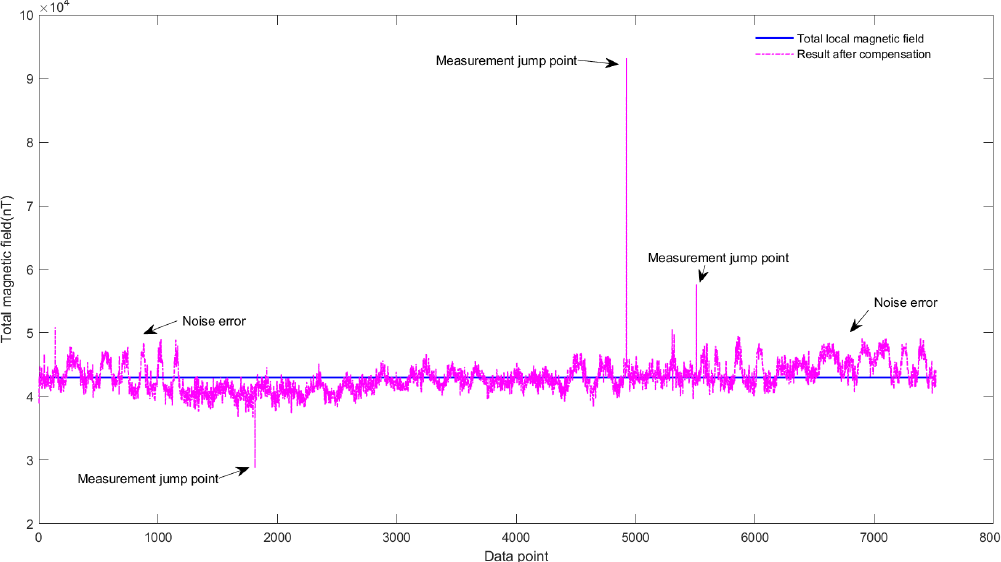
Figure 10. The influence of jumps and noise.